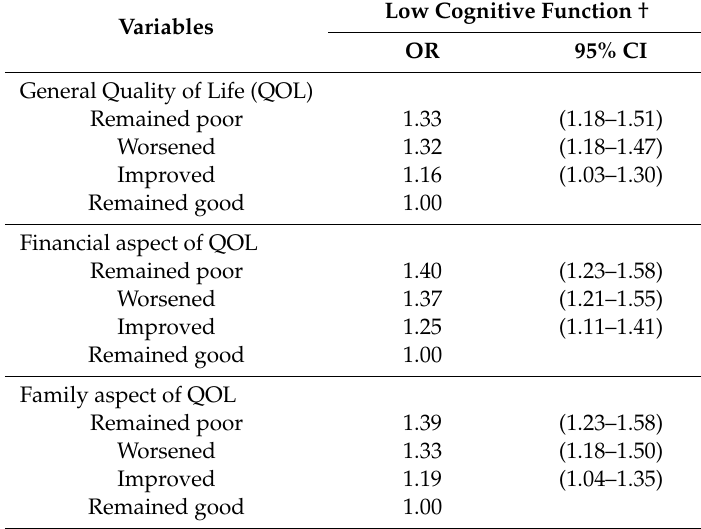
Table 2. Generalized Linear Model (GEE) * with low cognitive function measured by MMSE ‡ score. Low Cognitive Function † Variables